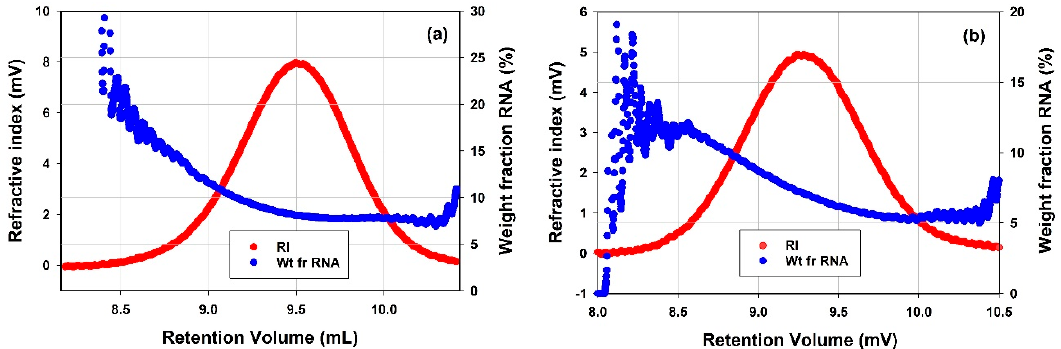
Figure 9. RI chromatograms of ( a ) mRNA-LNP1 and ( b ) mRNA-LNP2 overlayed with respective weight fraction of mRNA.